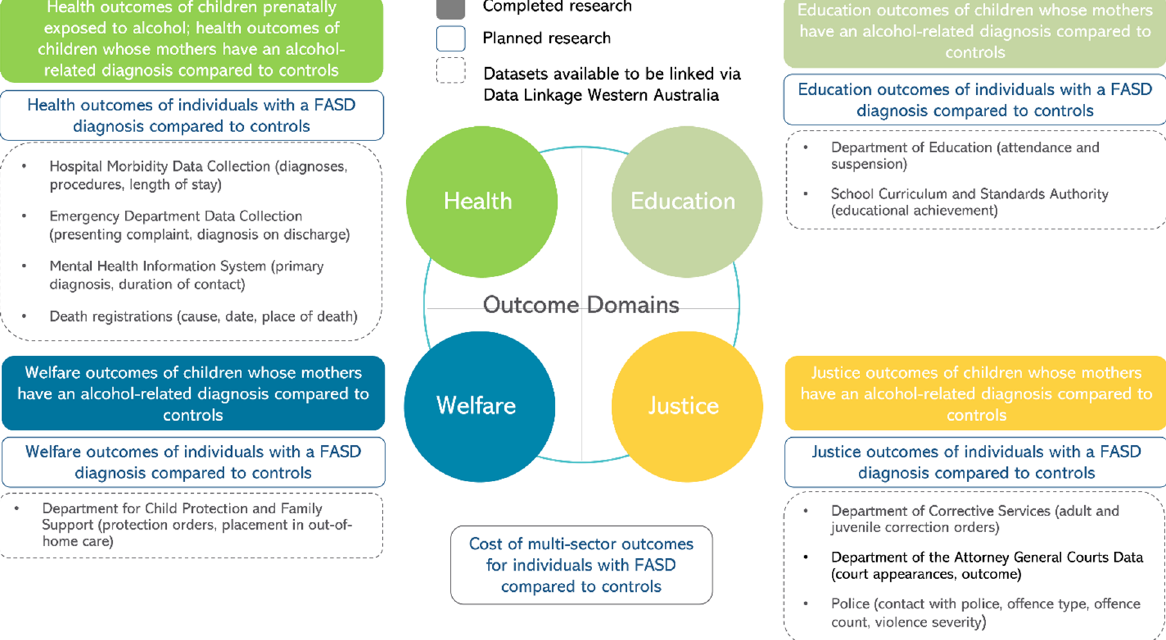
Figure 3: Overview of completed and planned work conducted using linked administrative